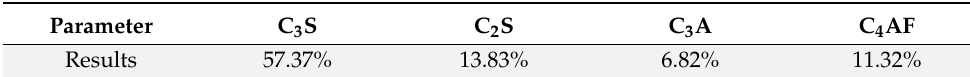
Table 2. OPC chemical analysis.